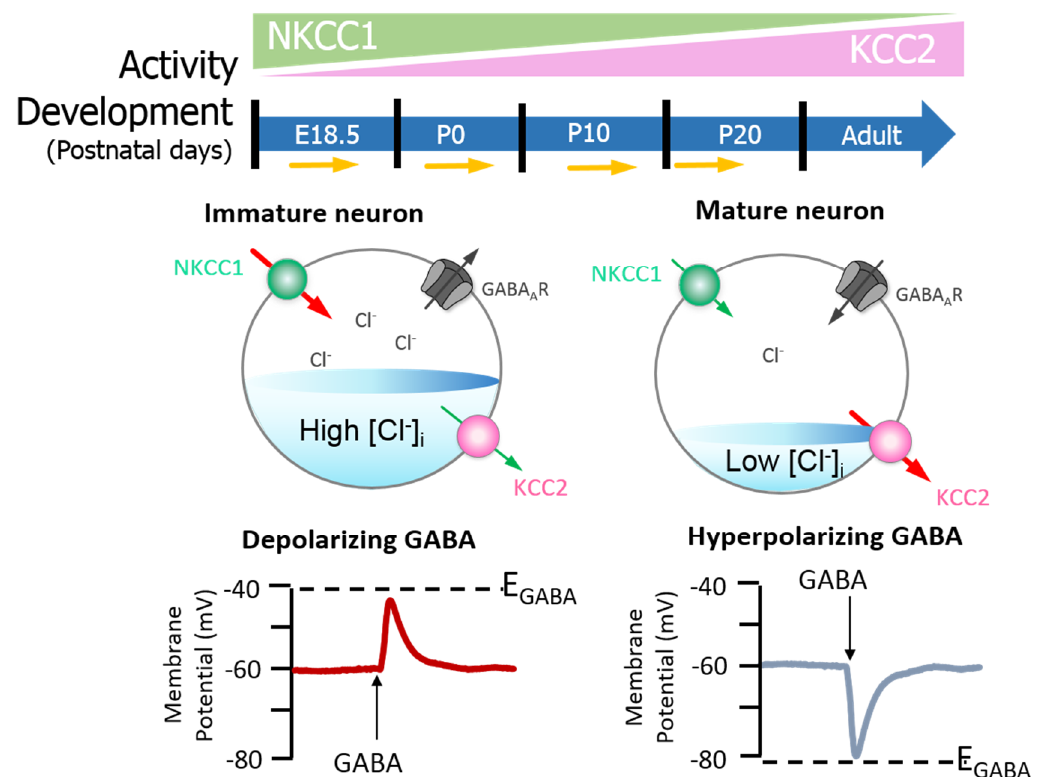
Figure 2. GABA A signalling shifts from depolarizing to hyperpolarising responses are mediated by developmentalexpressionofKCC2andNKCC1inthebrain(neocorticalneurons)ofrats. Thedi ff